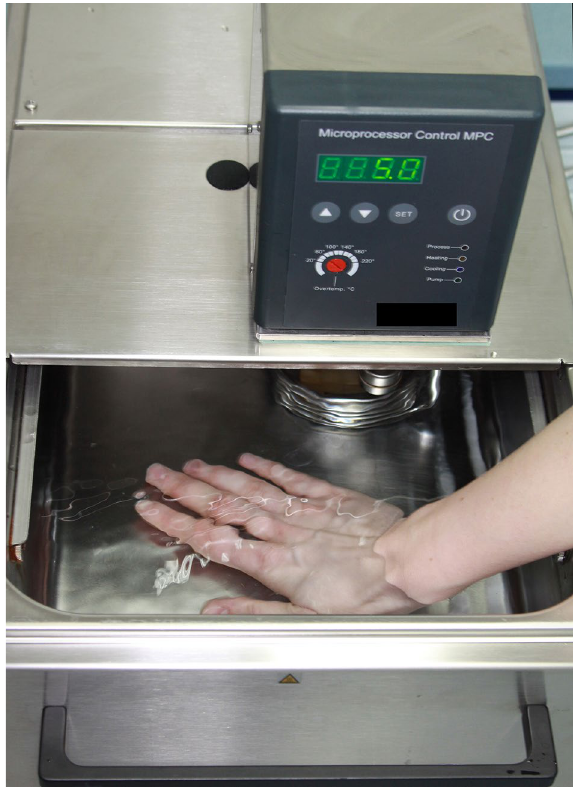
Figure 2. Circulating water bath system for the cold pressor test with immersed right hand. The water temperature was a constant 5 °C throughout the